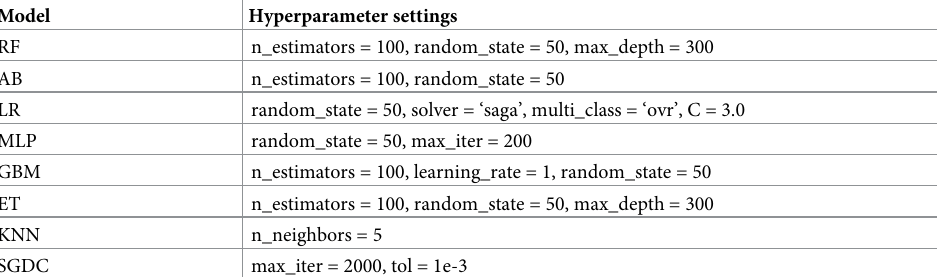
Table 2. Hyperparamter settings of supervised machine learning